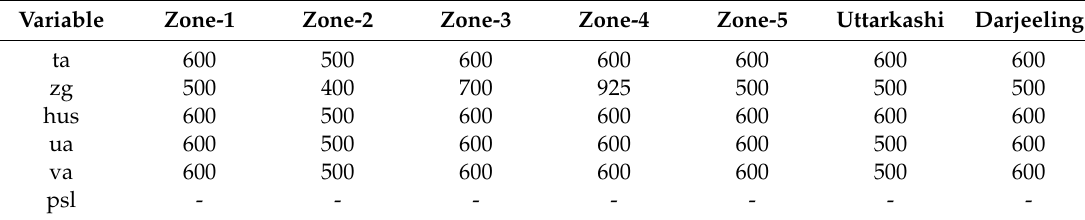
Table 6. Pressure levels (in mbar) for development of predictor-predictand relationship.